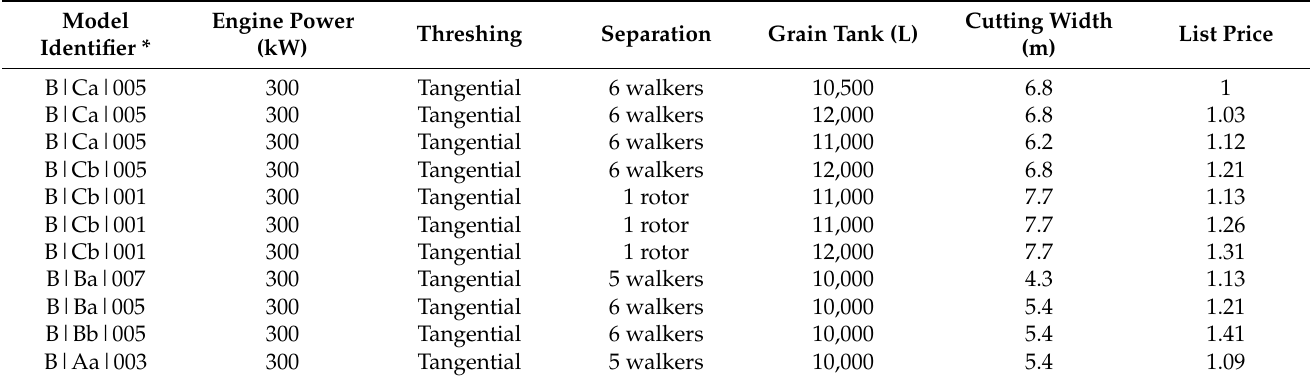
Table 1. A 300 kW combine list price (List Price relative to B|Ca|005 most cost-sensitive proposition as